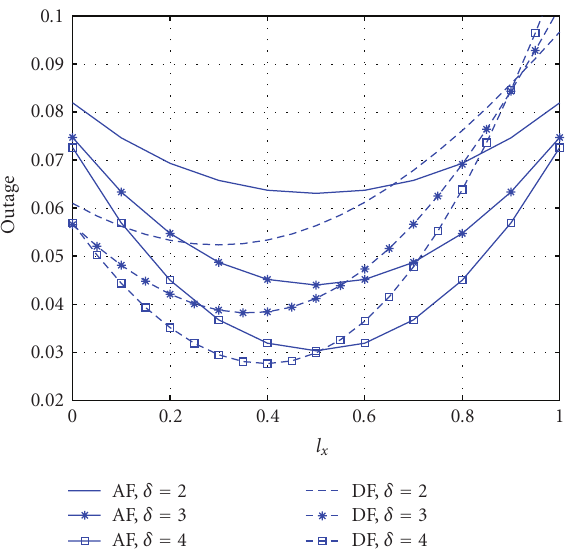
Figure 5: Outage probability versus the location of the relay, E s = 1, N 0 = 1, y = 0 . 5, and l SD = 1.